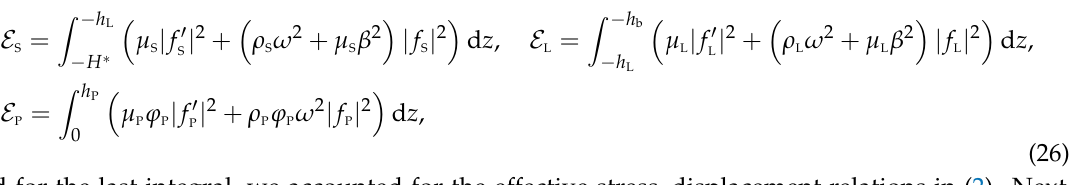
Figure 10. Left: Real part of the reflexion coefficient R c ω β . The dashed white line corresponds to an incident propagating wave at oblique incidence S ≥ with β = ω sin45 ◦ . Right: Repartition of the energies in the bottom and top heterogeneities c S (upper panel) and in the substrate, layer, and plate (normalized with the total energy); see the lower panel. Open symbols are obtained from direct numerics, Equations (24), and plain lines from the homogenized problem, Equations (26) and